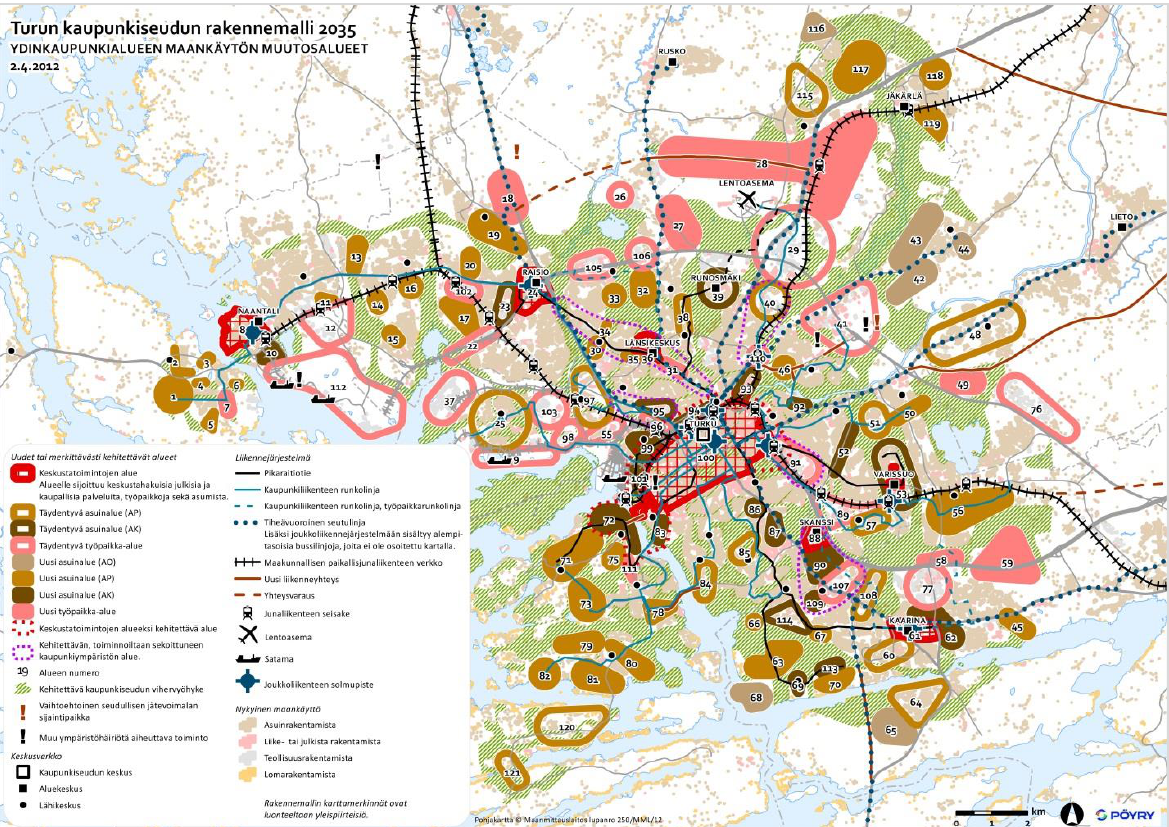
Figure 3. Regional structural model 2035. Source: City of Turku,